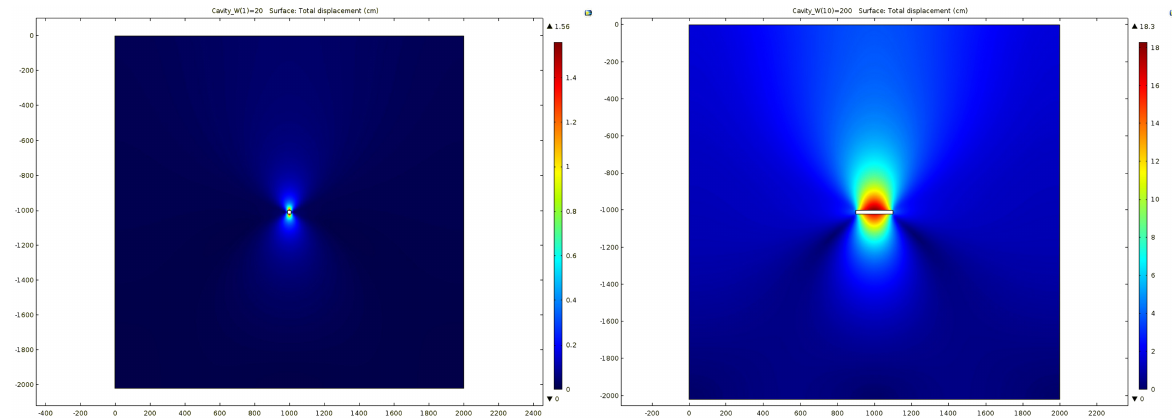
Figure 10. Total strata displacement around a deep seated